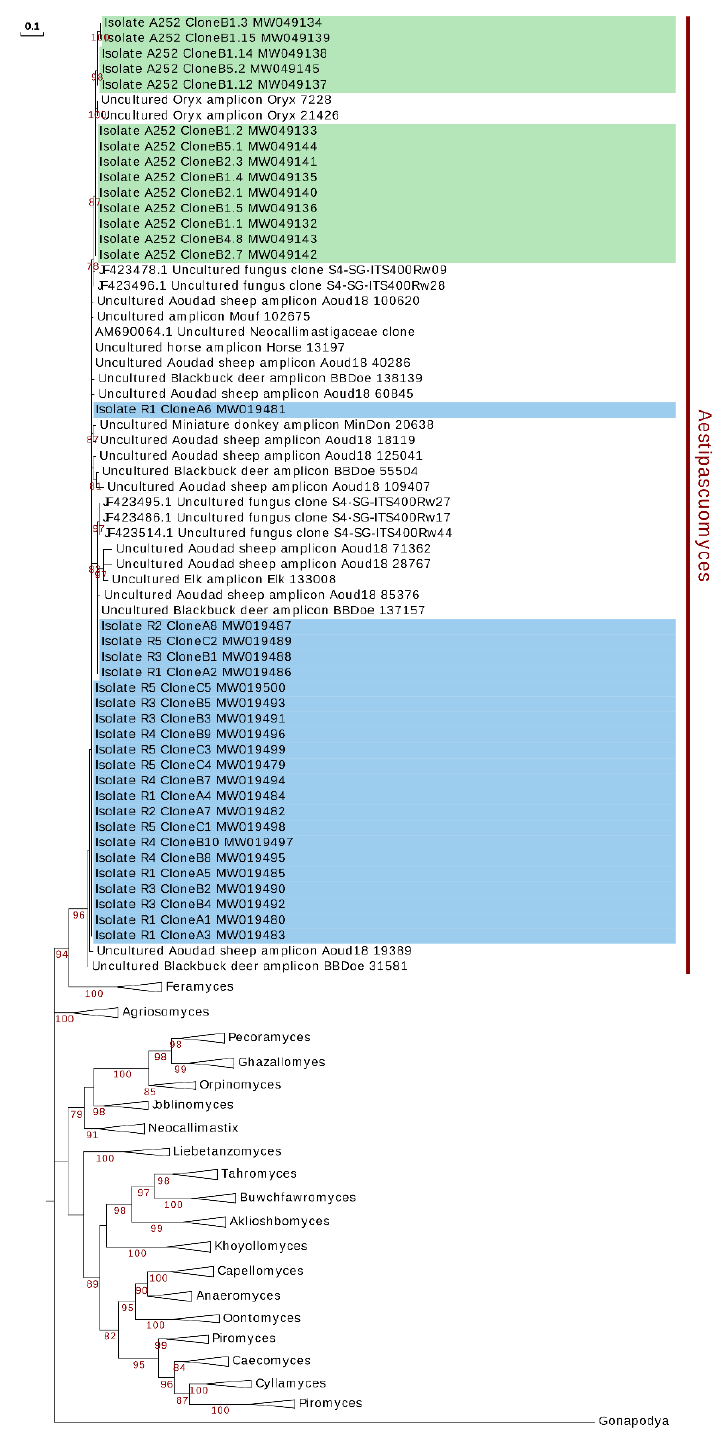
Figure 4. Phylogenetic a ffi liation of the Aestipascuomyces genus to other anaerobic gut fungi (AGF) genera based on the nucleotide sequences of the D1–D2 domains of 28S rRNA gene ( a ), and partial ITS-1 sequences ( b ). Sequences were aligned in MAFFT [30] and manually curated in BioEdit [31]. Curated alignments (LSU: 677 characters, 209 sequences; ITS: 295 characters, 126 sequences) were used to construct ML-trees using IQTREE with the predicted models TN + F + R2 (28S rDNA) or HKY + F + G4 (ITS) and –bb 1000. Bootstrap values are shown for nodes with more than 70% bootstrap support. Background color indicates the origin of the isolate (blue: Texas, USA; green: Baden-Württemberg,